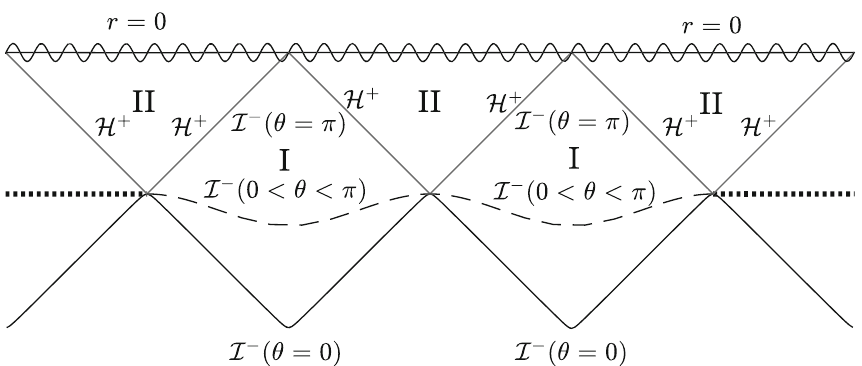
Fig. 4 Penrose diagram of the extremal accelerating black hole (2 mA = 1). In this case the singularity r = 0 is only in the future. H + refers to the future horizon, and I − to the past conformal infinity. The diagram is actually a superposition of different diagrams for each value of θ . The location of the conformal infinity depends on θ . It is